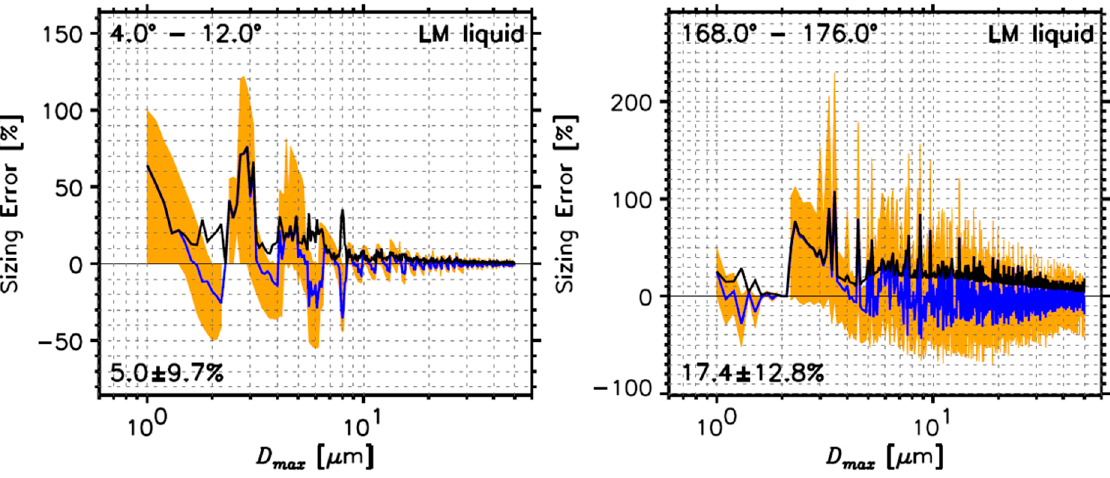
Figure 6. Determined sizing errors of spherical liquid cloud droplets at forward (4°–12°, left ) and backward (168°–176°, right ) scattering angles. The sizing errors are calculated using an exact comparison between the measured D max of liquid cloud droplets and those determined by a Lorenz–Mie code assuming spherical liquid cloud droplets (LM liquid). The minimum and maximum sizing errors are the lower and upper boundary of the orange shaded area where the sizing errors of all possible selections exist. The blue lines indicate the averaged sizing errors of all possible selections for a given size of the sphere, while the black lines are the average of the absolute values of sizing errors of all possible selections. The average and standard deviation of the black line across all sizes are also embedded in each panel.